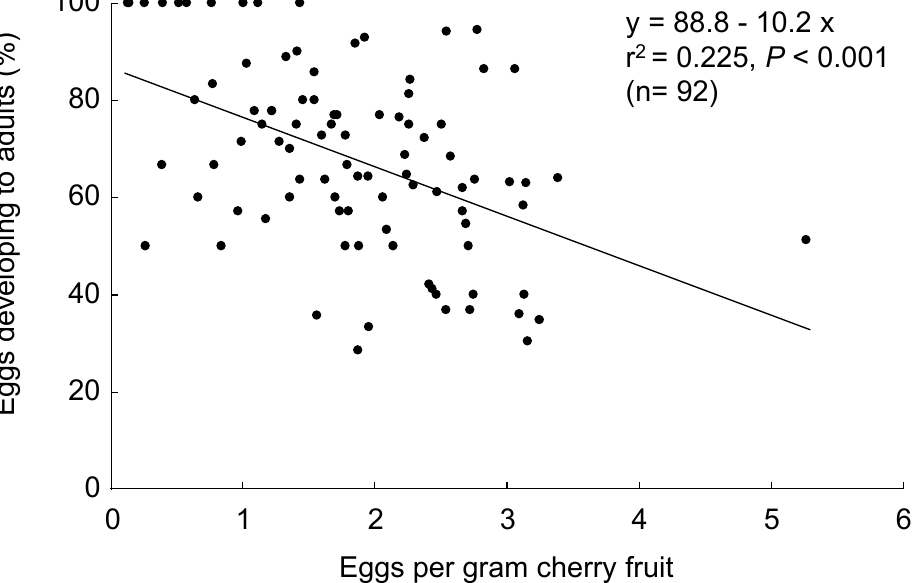
Figure 1. Preference by adult female D. suzukii for two different sized cherry fruit: ( A ) Number of eggs laid per fruit, ( B ) number of eggs per gram of fruit, and ( C ) percentage eggs developed to adults. Bars refer to mean ± SE, and different letters over the bars indicate significant difference (One-way ANOVA, p < 0.05).